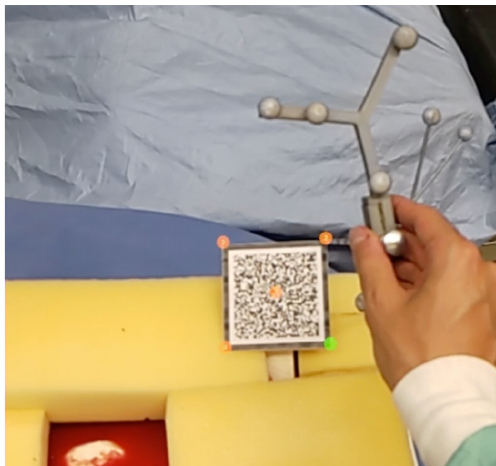
Figure 4. The simulation setup for our user study consisted of a tracked hip phantom and a tracked angled endoscope. The live view of the virtual endoscope, as well as the target view, were displayed on an external monitor.